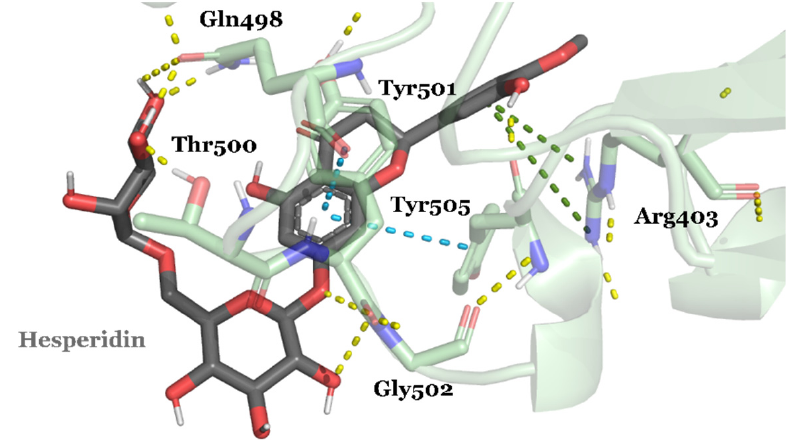
Figure 7. A representative snapshot of the docking pose of hesperidin with the Beta variant. B.1.351 (Beta’s) residues are colored according to the atom type of the interacting amino acid residues (protein’s carbon, pale green; oxygen, red; nitrogen, blue). Dash lines represent the protein–ligand interactions: hydrogen bond interactions are colored in yellow; π - π interactions are colored in blue; π -cation interactions are colored in green.